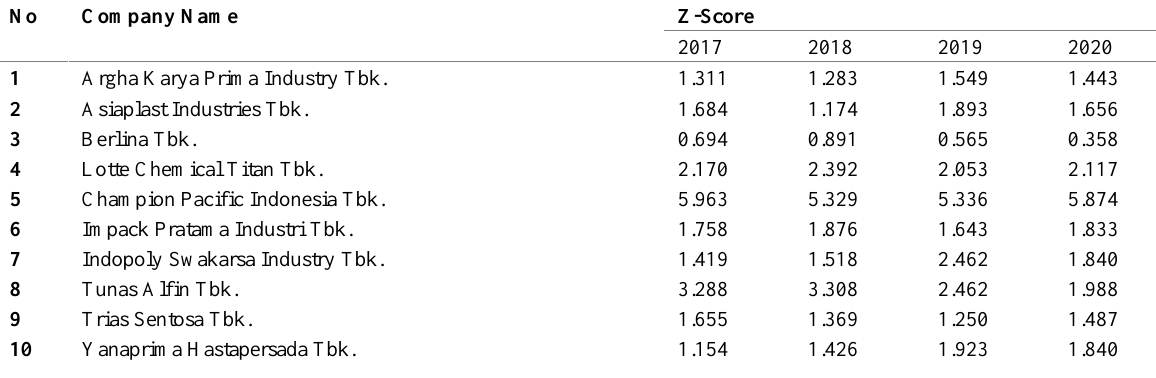
Table 6 : Analysis of Altman Z-Score Model